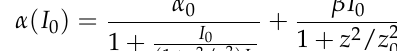
Figure 3. The physical mechanism of the NLO properties of Ag@V 2 C monolayer flakes. ( a ) One photon absorption. ( b ) Two photon absorption.